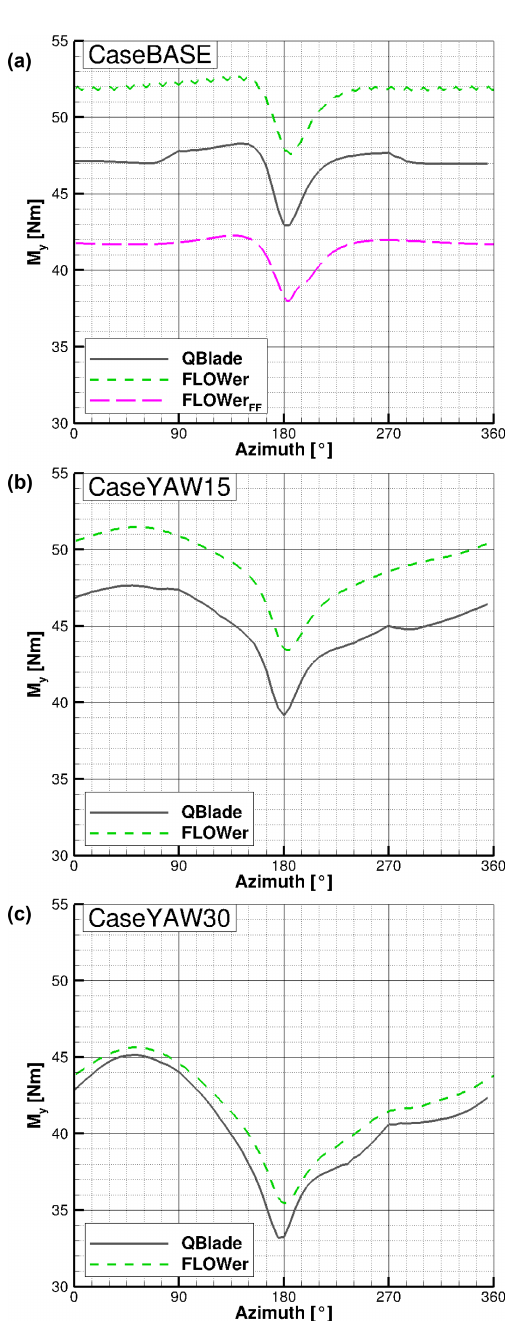
Figure 19. Simulated flapwise bending moment ( M y ) over the az- imuth for CaseBASE (a) , CaseYAW15 (b) and CaseYAW30 (c) for QBlade and